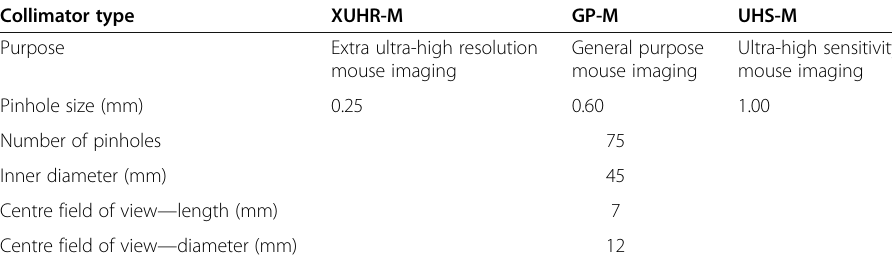
Table 1 Specifications of the used